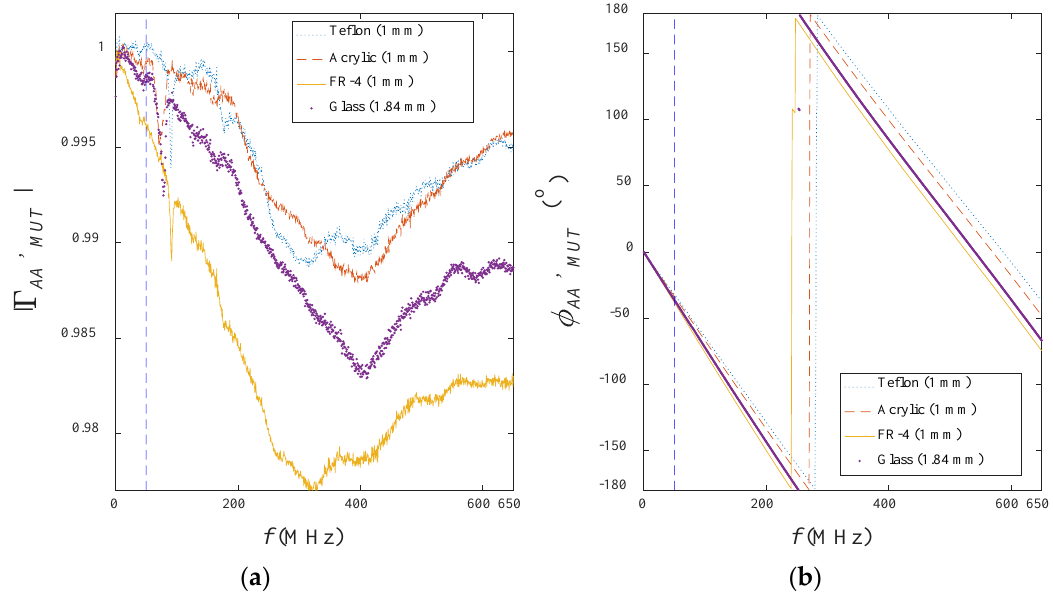
Figure 9. Variation in ( a ) measured |Γ AA ′ _MUT | and ( b ) measured φ AA ′ _MUT with frequency for the four materials under test (MUTs) at room temperature.